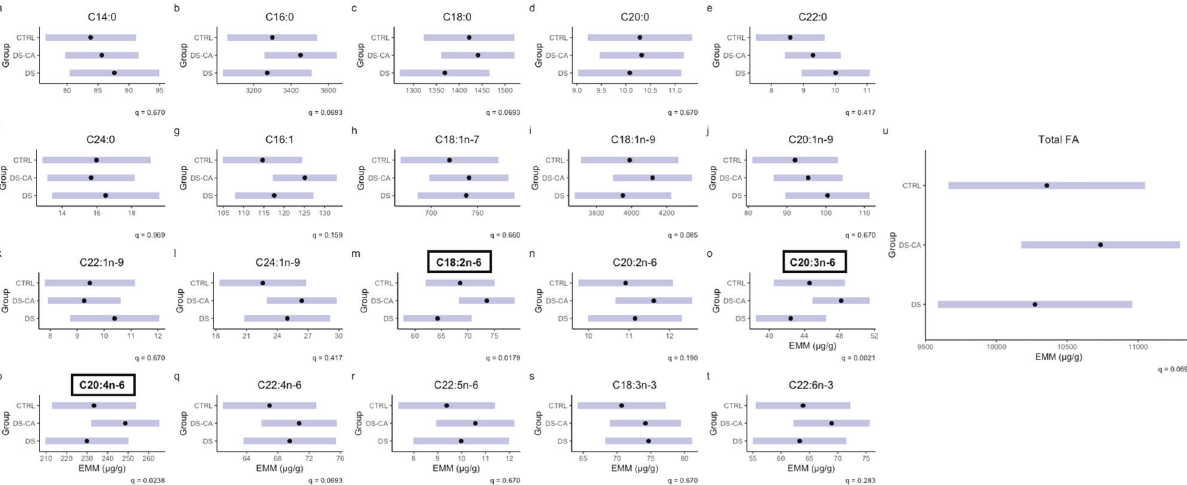
Fig. 2 Concentration of fatty acids in choline glycerophospholipids between groups. Black dots represent the estimated marginal means for the group and purple bars represent the 95% con fi dence intervals based on linear models for the concentration of FA as a function of the group with age, PMI, pH, and sex as covariates. Subplots with boxed titles in bold font indicate signi fi cance between groups with q < 0.05. Concentrations are represented in